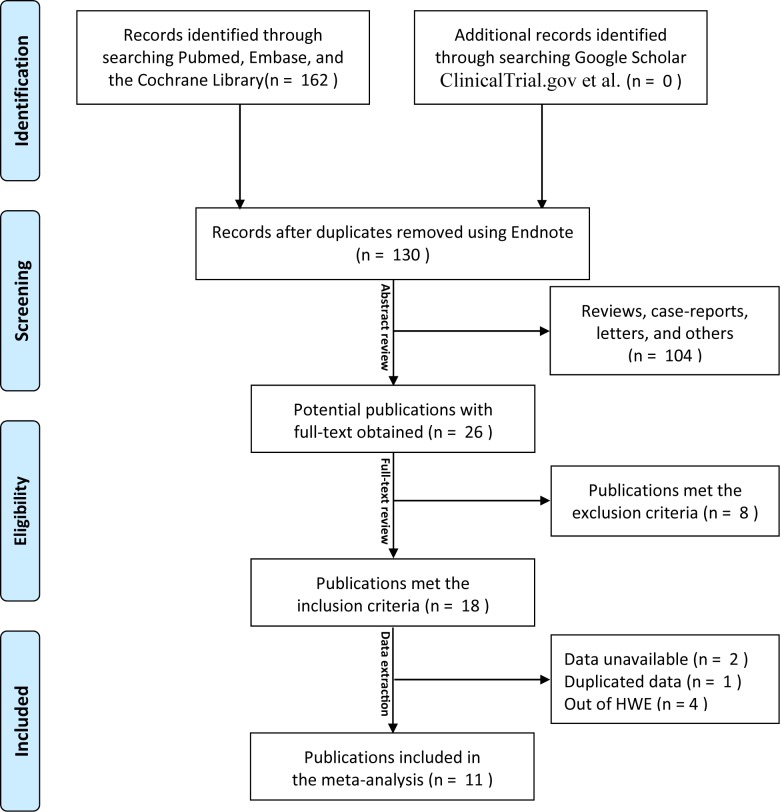
Flow diagram of search and selection for studies.